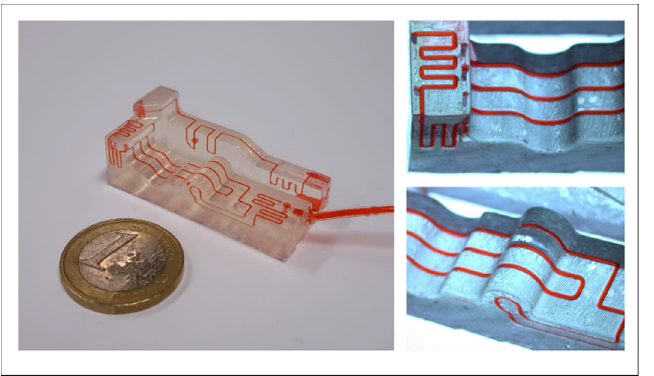
Figure 2. Testing device covering several challenging geometries and displaying the flexibility of the method.